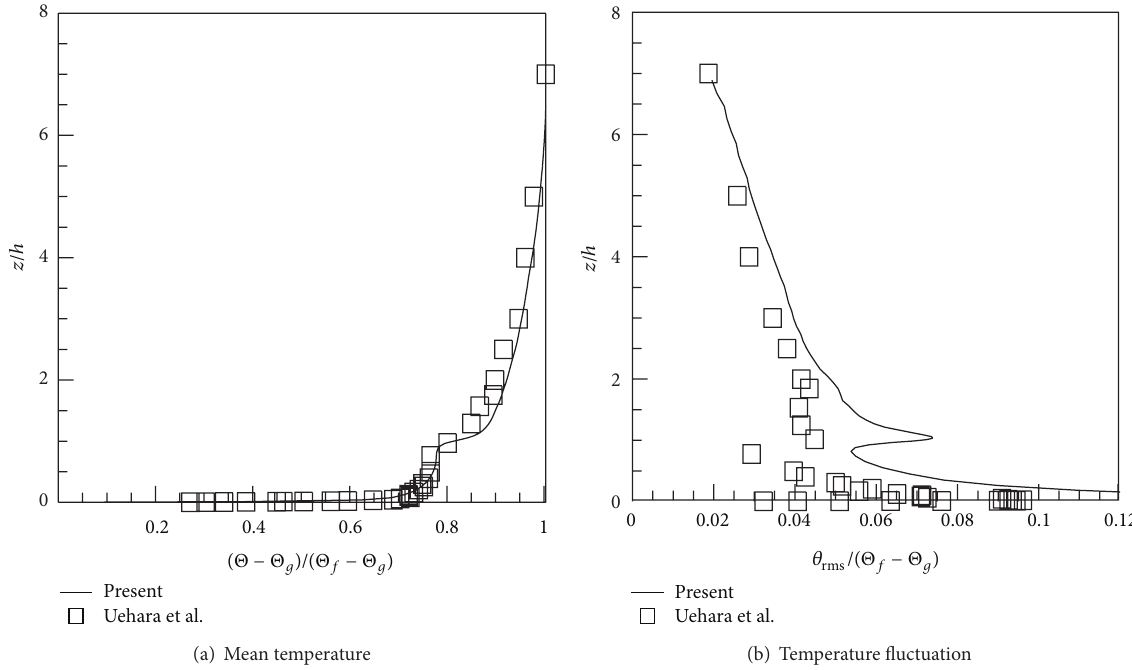
Figure 10: Vertical profiles of mean temperature and turbulent intensity for temperature 𝜃 − Θ ) (Θ 𝑓 𝑔